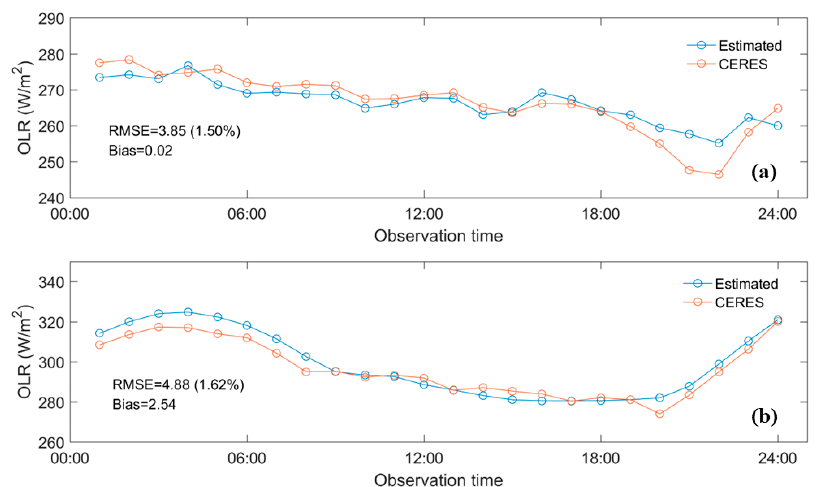
Figure 4. Intercomparison of the AHI and CERES hourly TOA OLR on 1 November 2017 at ( a ) (25°N, 125°E) and ( b ) (25°S, 150°E).